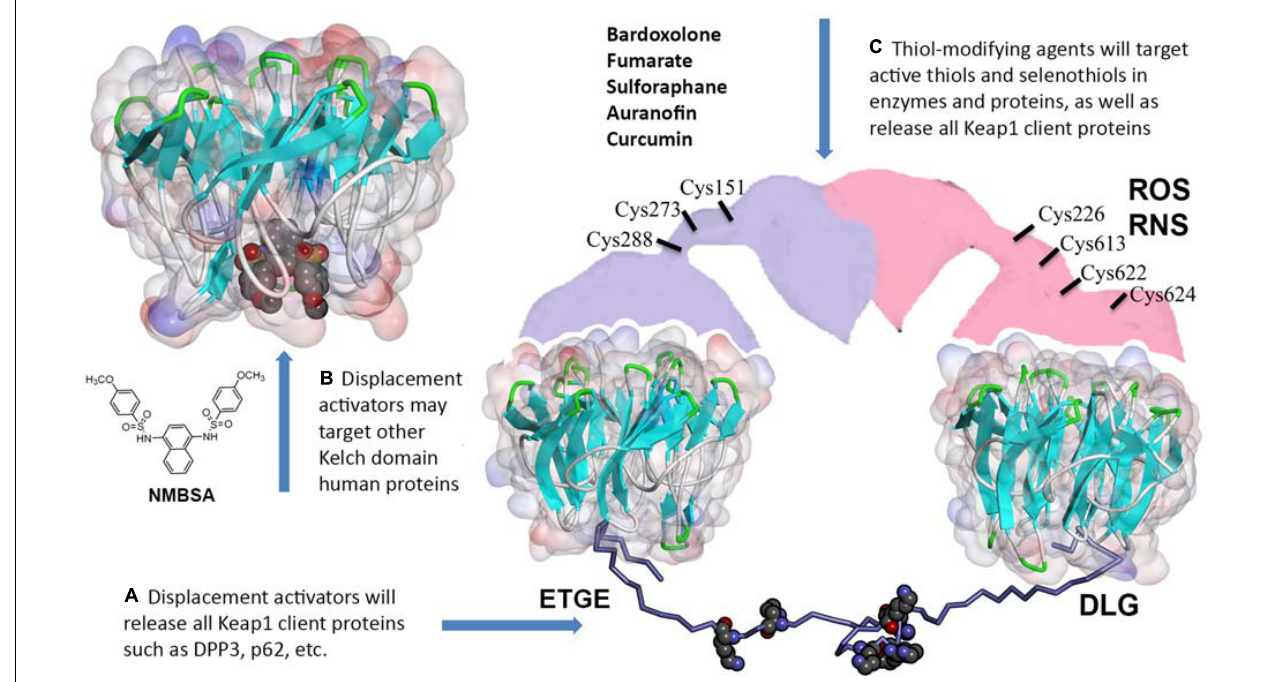
FIGURE 2 | Off-target effects of Keap1 pharmacological targeting. (A) Thiol-modifying agents as well as displacement activators of Nrf2 (both peptides and small molecules) will release all other Keap1 client proteins. (B) Small molecule displacement activators may target Kelch domains in other proteins. (C) Thiol-modifying agents (bardoxolone and others) will inactivate redox active thiols and selenothiols in other proteins. The model for 16–85 aa Neh2 peptide (lysine residues shown with WdW radii) stretched between two Kelch domains was built using Kelch crystal structures with the corresponding Nrf2 binding motifs (4IFL.pdb and 2DYH.pdb) distanced at ca. 80 Å in accord with the Keap1 dimer conformation reported in Ogura et al. (2010). Full description of the modeling procedure is in